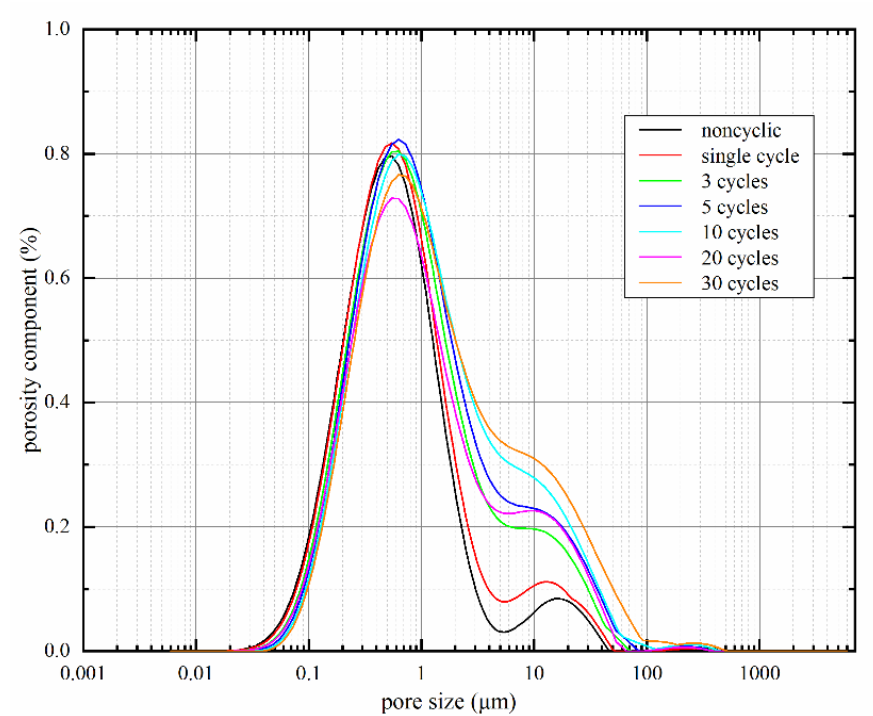
Figure 9. Pore size distribution patterns of Yili loess samples after different numbers of drying– wetting cycles.